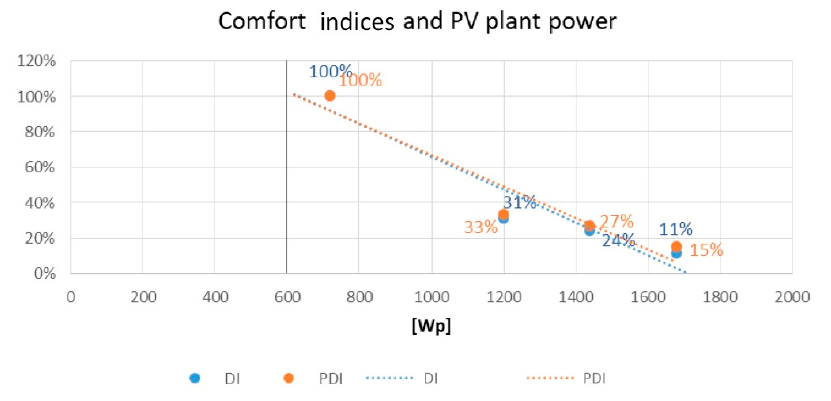
Figure 13. Yearly comfort indices for the tested PV plants.